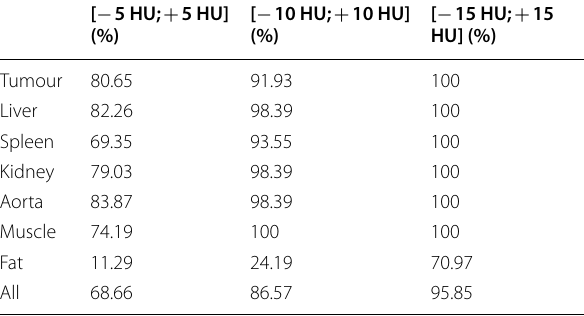
Table 2 Differences in attenuation values between the TNC